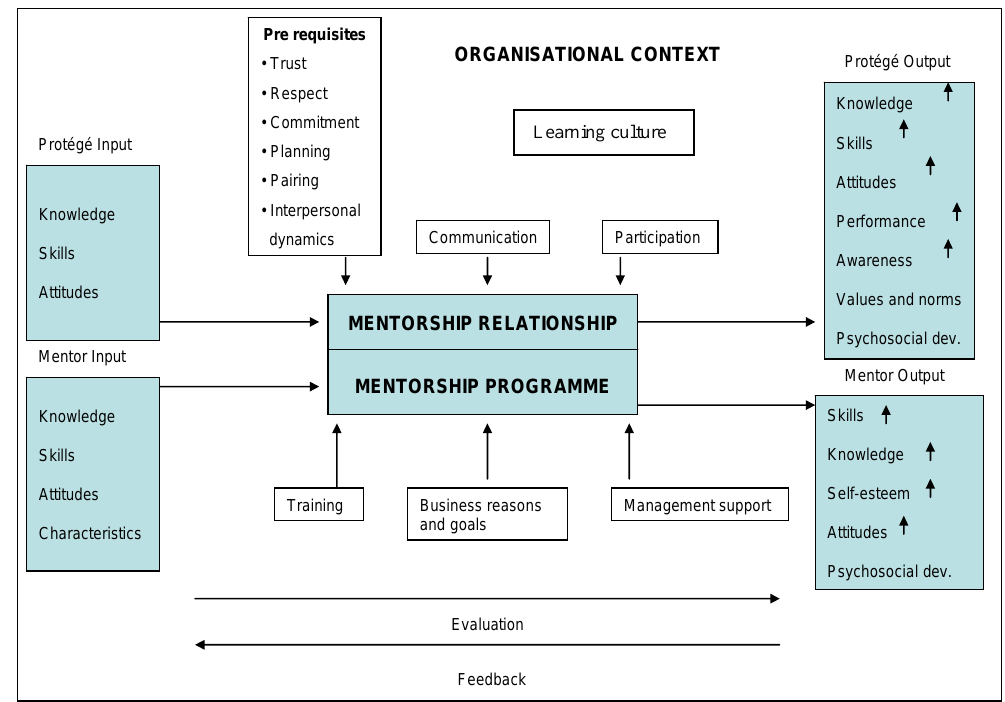
Figure 2. Mentorship in organisations: A systems view (Authors own